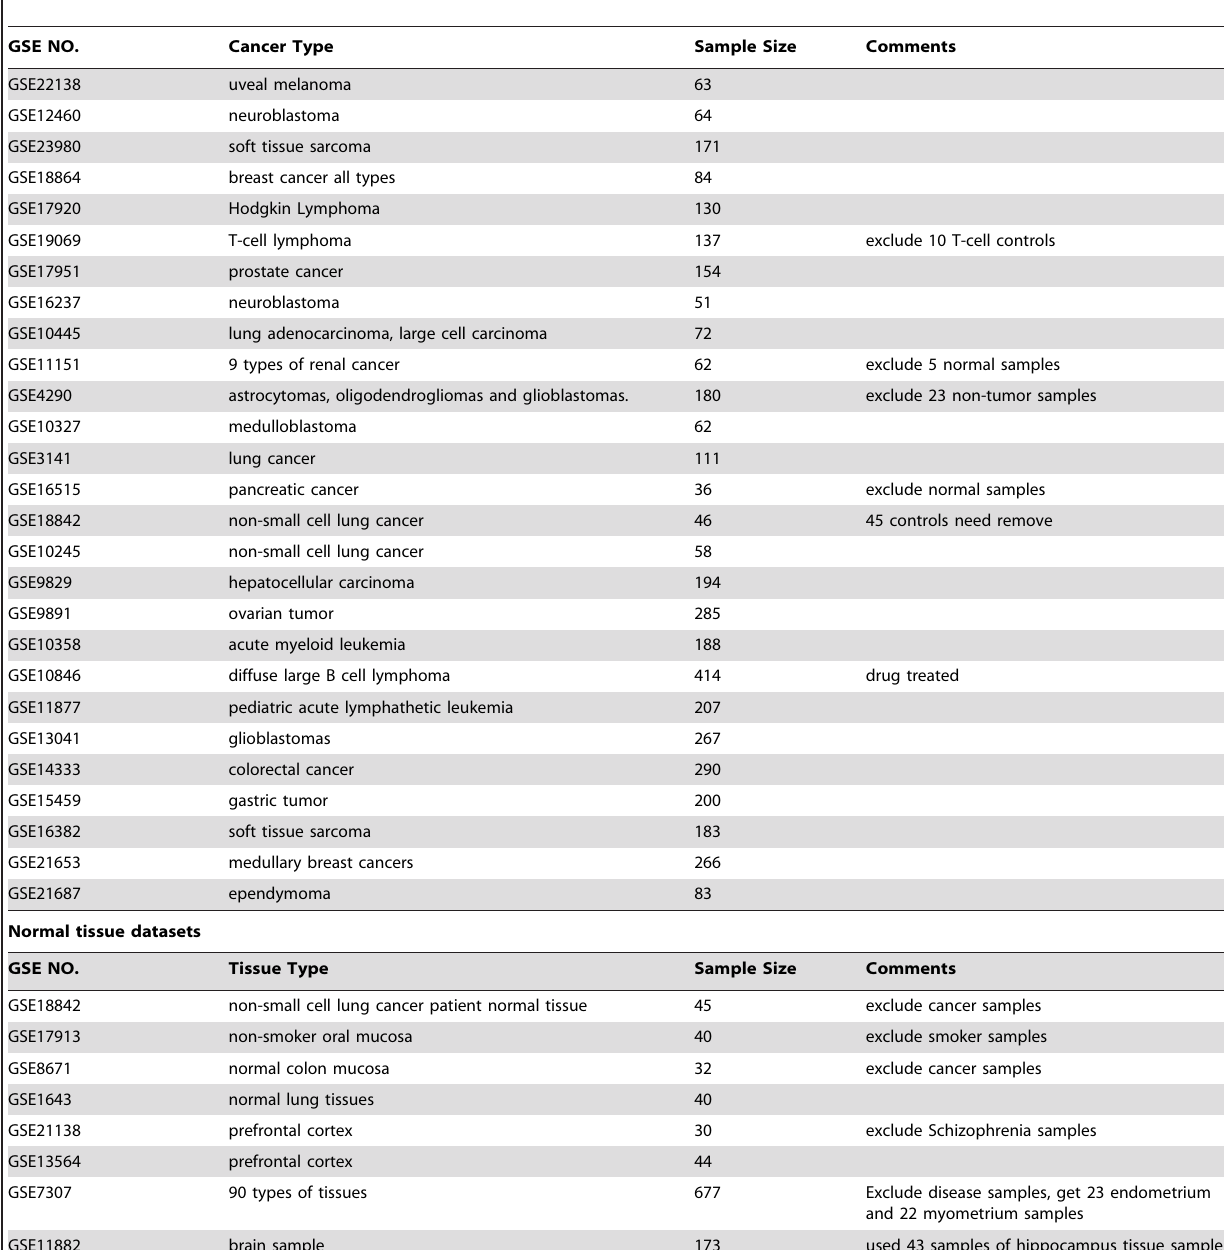
Table 1. Summary of the sample information for microarray datasets used in the study.